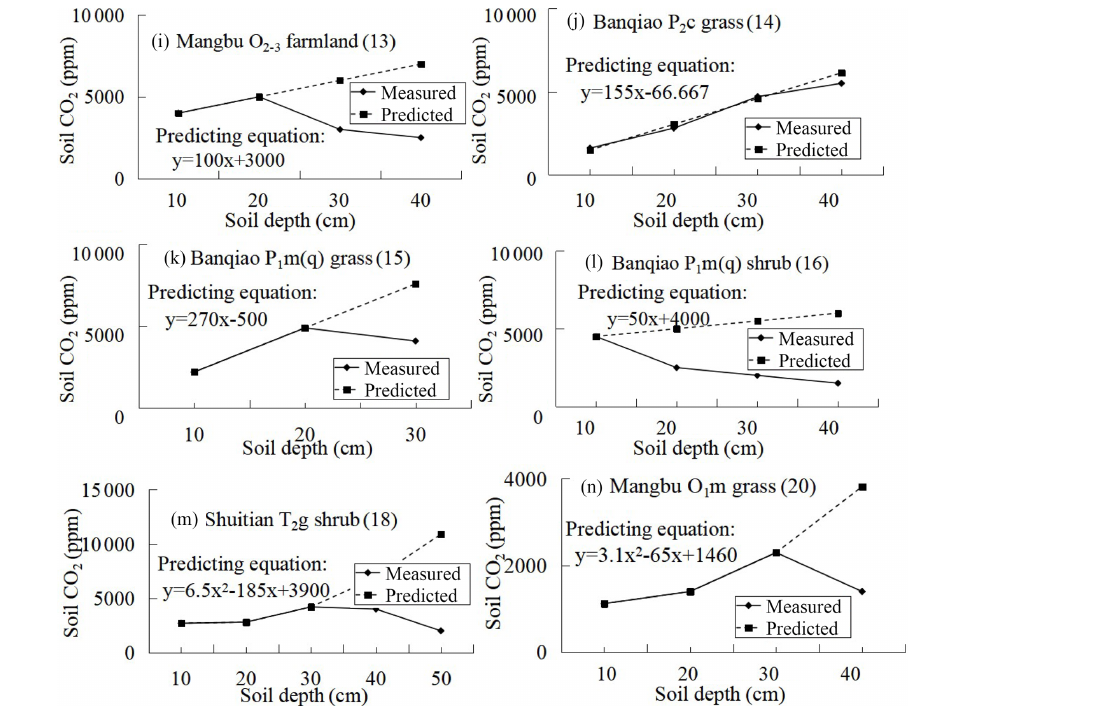
Figure 8. The measured and predicted soil profile CO 2 concentrations in carbonate areas.